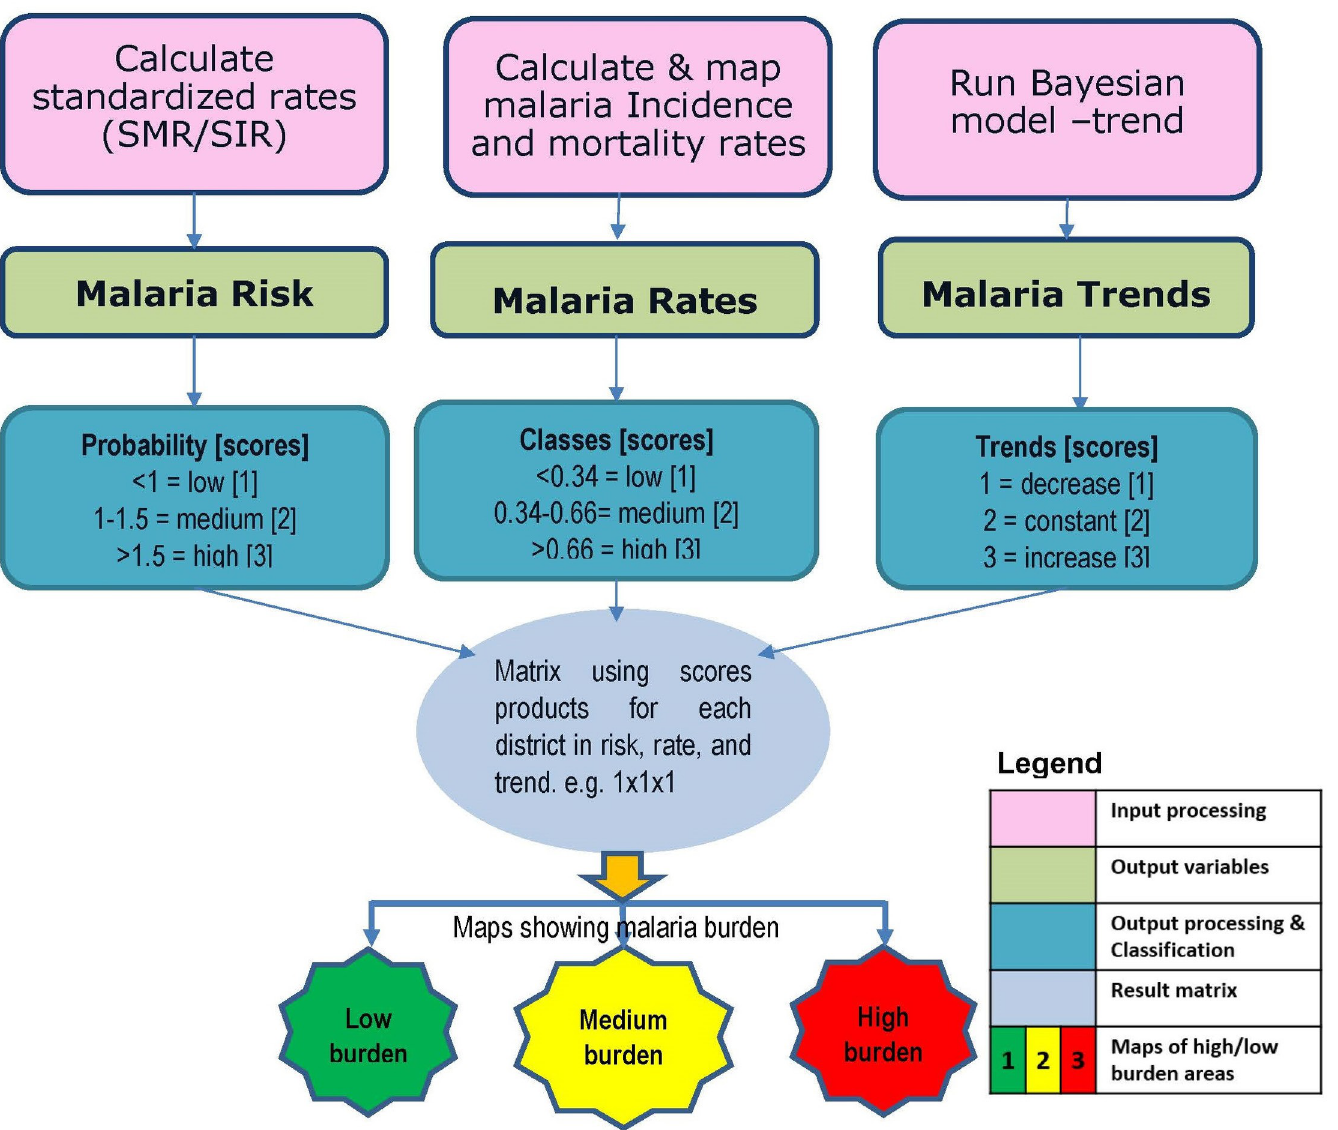
Fig 6. Data preparation and processing to determine areas of highest/lowest burden. Stages of data analysis from initial, intermediate, to final outputs. The classes relate to 1, 2, 3 scores with 1 = low, 2 = medium and 3 = high applied to risk, rates, and